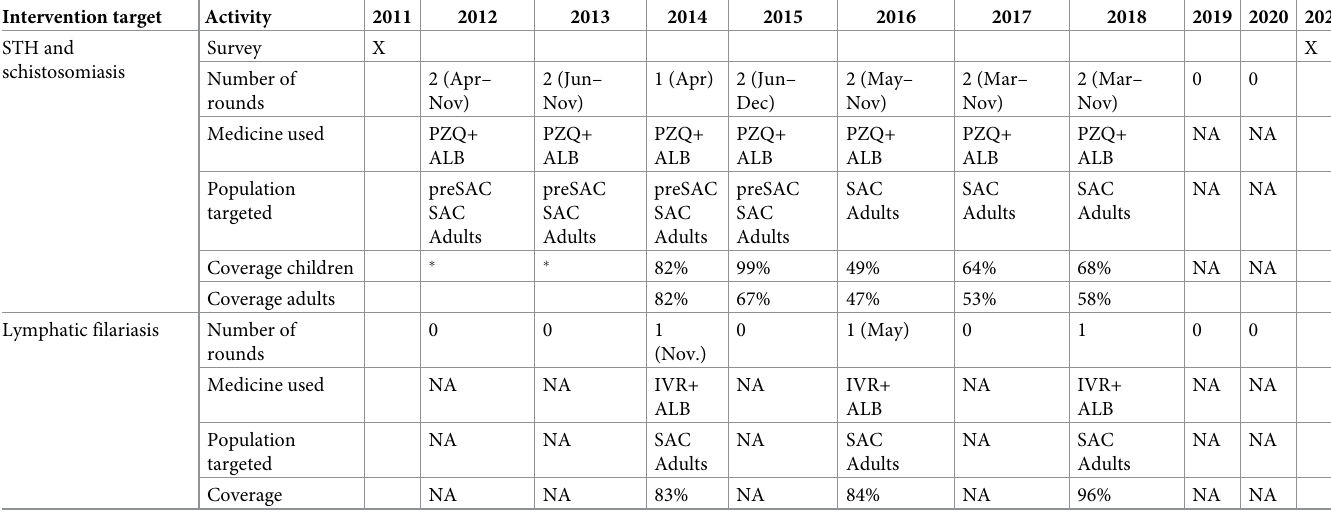
Table 1. Preventive chemotherapy activities conducted in Pemba and their coverage according to reports from MoH Zanzibar to WHO. Intervention target